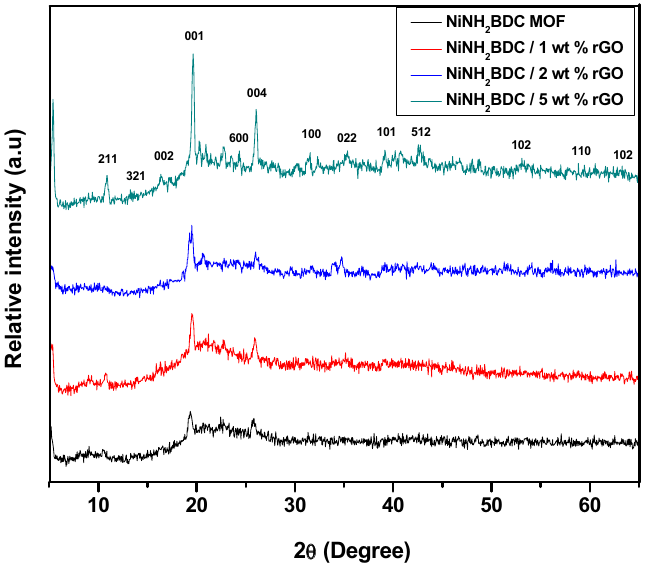
Figure 3. X-ray diffraction pattern of NiNH 2 BDC MOF/1, 2, 5 wt% reduced graphitic carbon